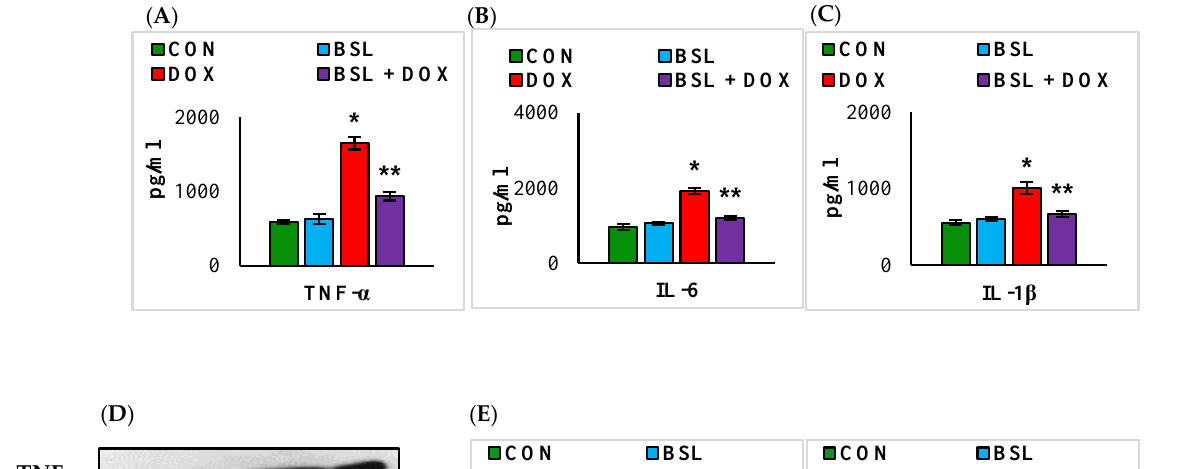
Figure 3. Effect of α -bisabolol on the levels/expression levels of pro-inflammatory cytokines. ( A – E ) Effect of α -bisabolol on the levels/expression levels of pro-inflammatory cytokines (TNF- α, IL - 1β , and IL-6) in the testis. Each column is mean ± SEM for eight rats in each group; columns not sharing a common symbol (*, **) differ significantly from each other (* p < 0.05 vs. normal control, ** p < 0.05 vs. DOX control), CON-Control, BSL- α -Bisabolol, DOX-Doxorubicin, BSL + DOX- α -Bisabolol + Doxorubicin.